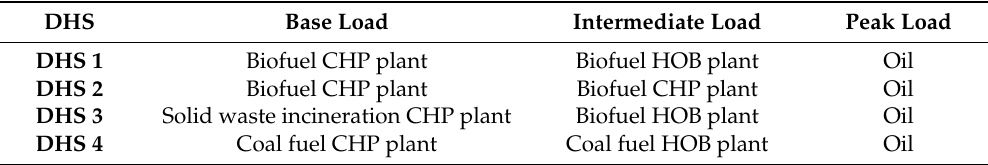
Table 3. The different composition of production units in evaluated DHS.